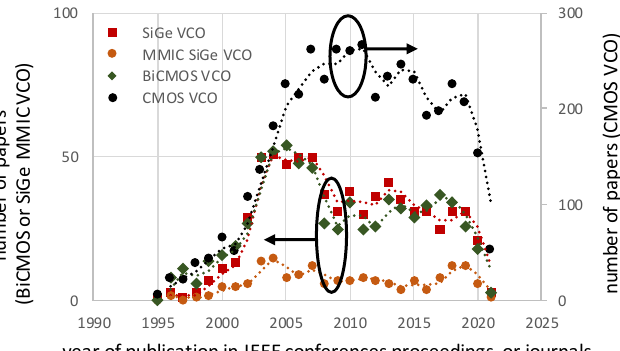
Figure 4. Publication trend between 1995 and 2020. Selection was made by keywords as proposed in the upper-left